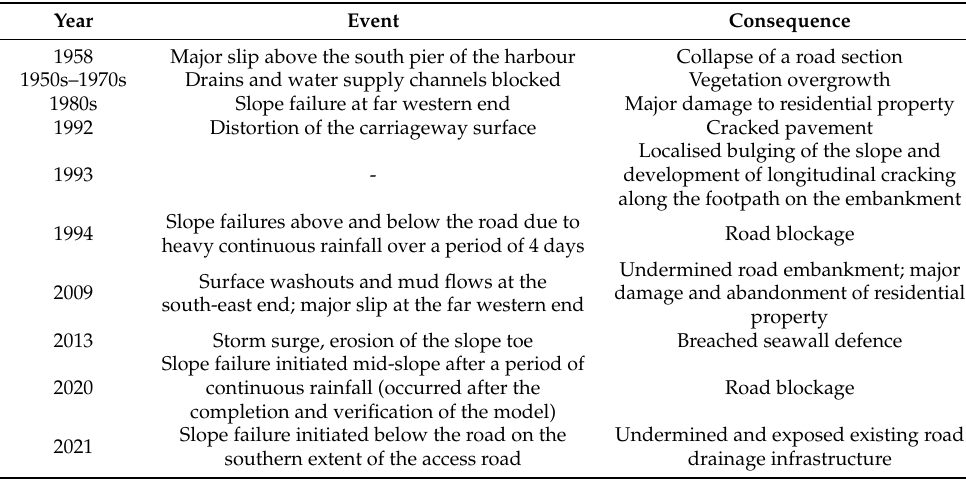
Figure 3. ( a ) typical translational slips; ( b ) typical deeper-seated slips on the study site. Table 1. Historic records of failures on the slopes of the case study Table 1. Historic records of failures on the slopes of the case study site.